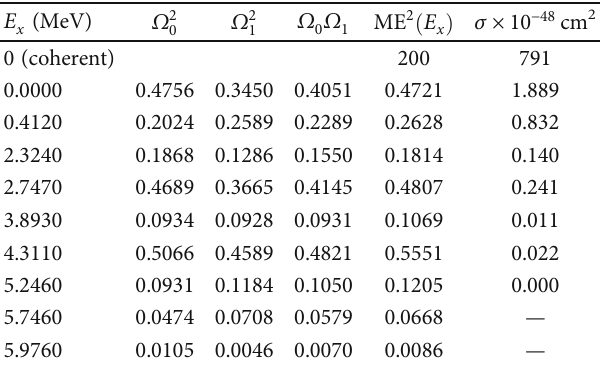
Table 2: Isoscalar and isovector spin-dependent matrix elements of 23 Na from the ground ( 3/2 + ) to the various excited states entering gs the axion-induced photoproduction. We also include the total Þ , including the spin-independent nuclear matrix elements ME 2 ð E x one appearing in the coherent mode, which contain the factor ð 1 − ð E ÞÞ 3 related to the photon energy, and the relevant / E x a cross sections as well. Note that states up to the axion energy of 5.5 MeV are